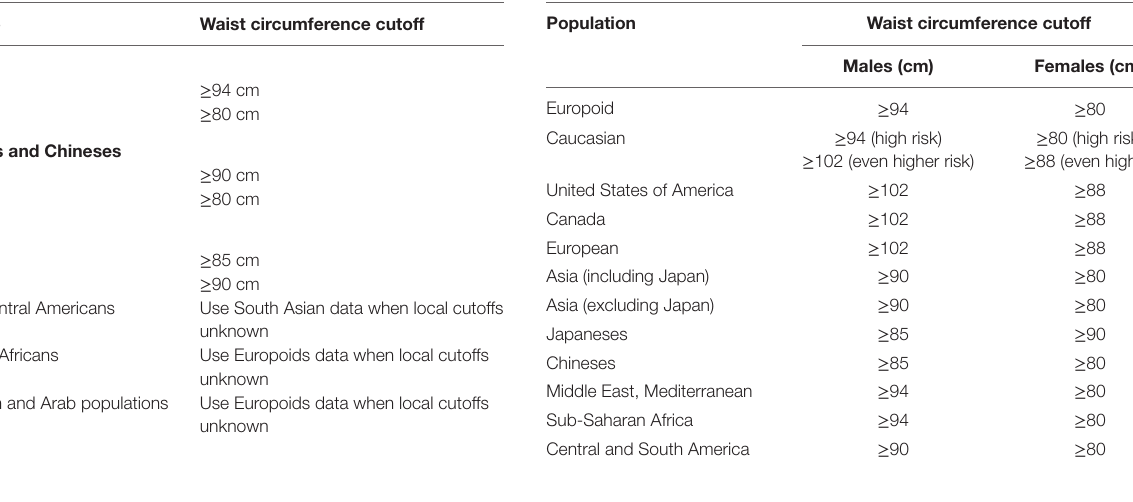
TaBle 4 | Cutoff values for waist circumference, by ethnic group, for the definition of central obesity in the harmonized criteria (International